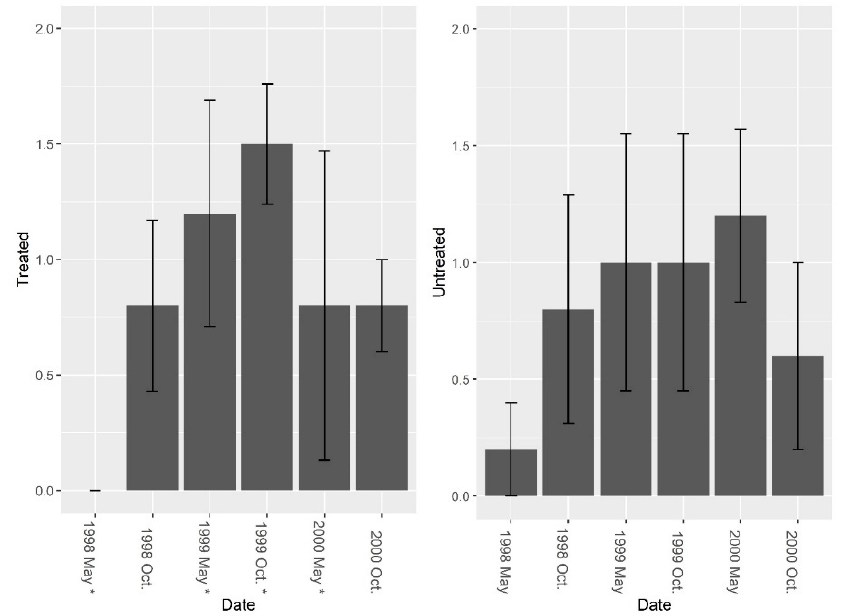
Figure 3. Mean ( ± 1 SE) ant (excluding fire ant) species richness collected from burrow baits at five pairs of treated and untreated study sites at CSJFTC, 1998–2000. There were no significant differences between study sites from a randomized block design ANOVA (F = 1.0, df = 4, P = 0.374). Asterisks on the x-axis indicate when treatments occurred.